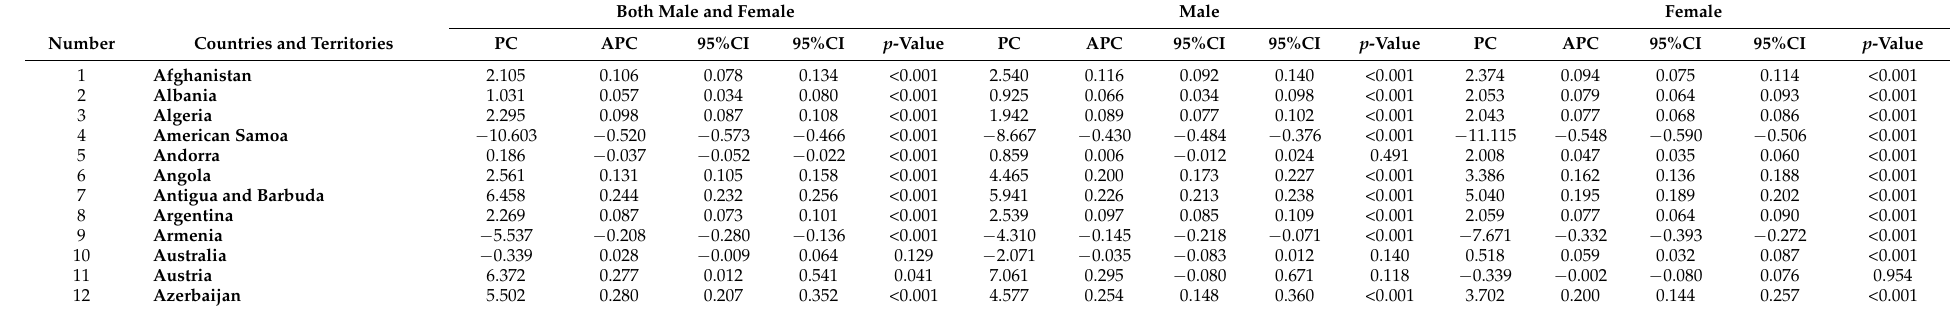
Table 3. Percentage change and annual percentage change of age standardized incidence rate of urolithiasis stratified by gender and 195 Countries and